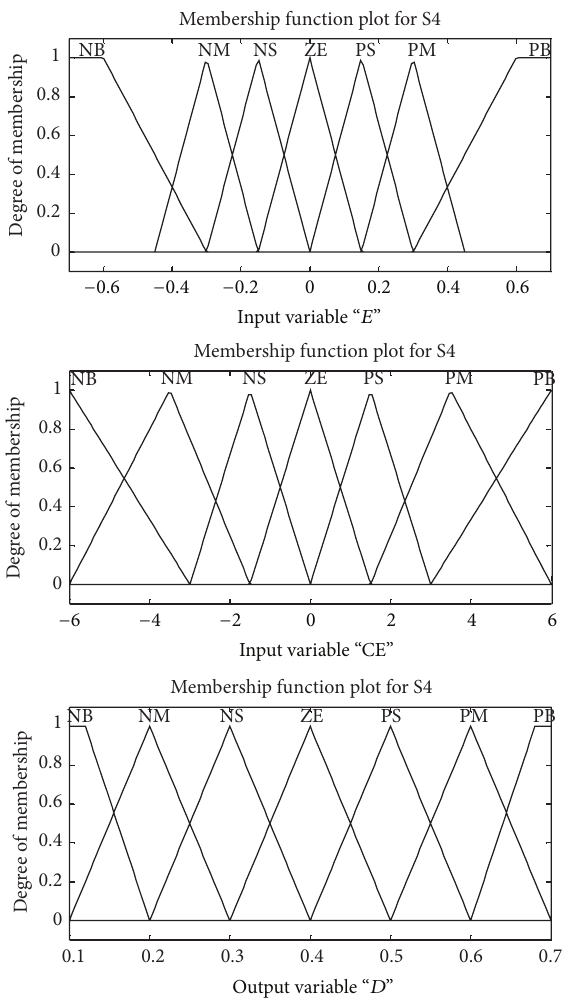
Figure 12: The membership functions of 𝐸 , CE, and 𝐷 for S4.